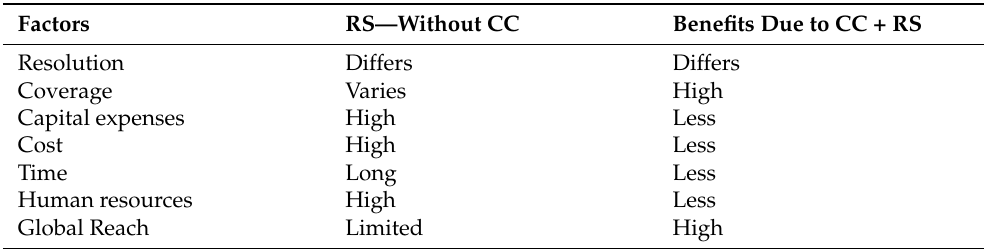
Table 5. Cloud computing- and remote sensing-highlighted benefits and the different economic factors they influence in